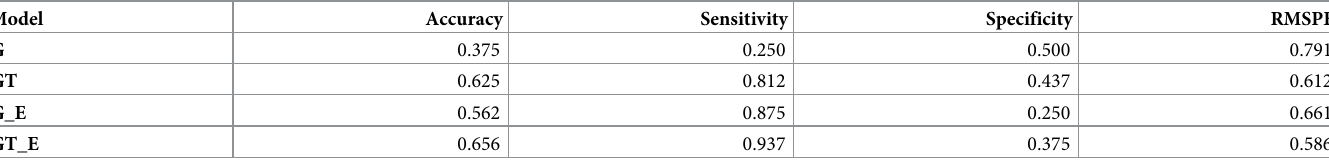
Table 3. Predictive performance of each model based on accuracy, sensitivity, specificity and root mean-square prediction error (RMSPE).